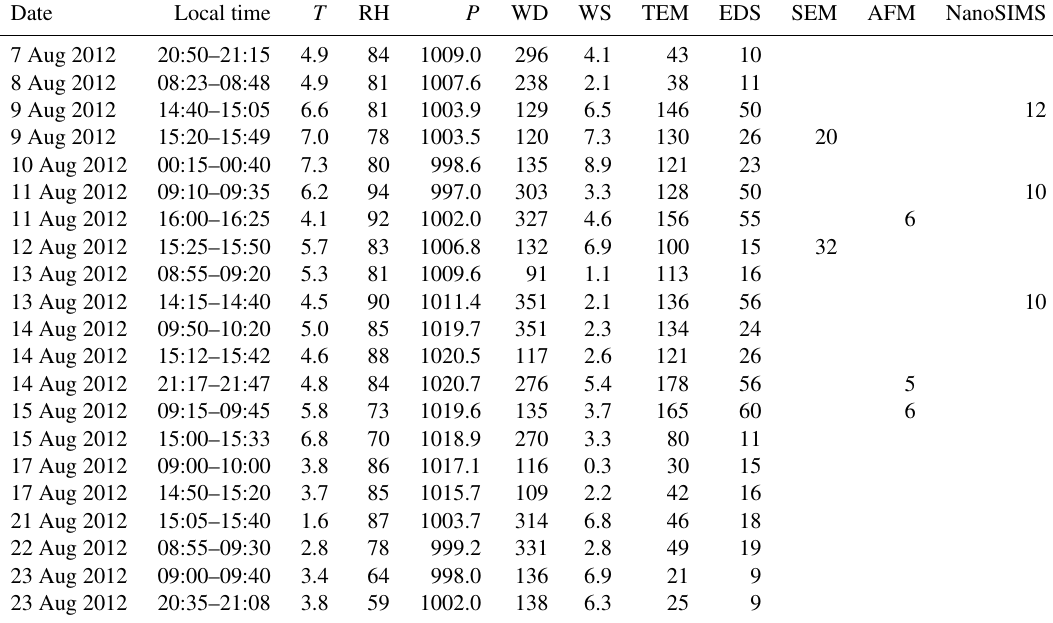
Table 1. Sampling information in Arctic area and their